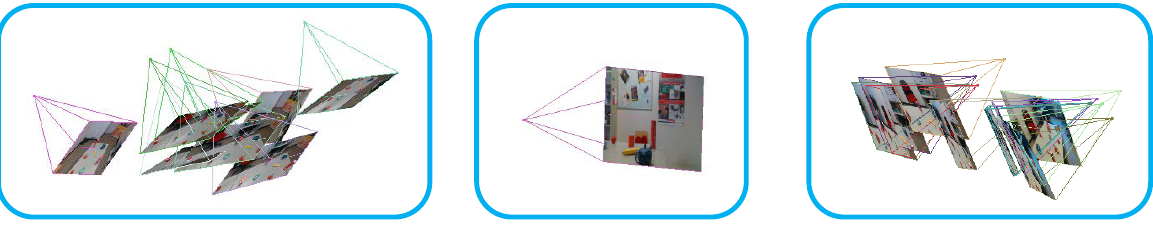
Figure 5. The local pose groups. They are clustered based on angle and distance